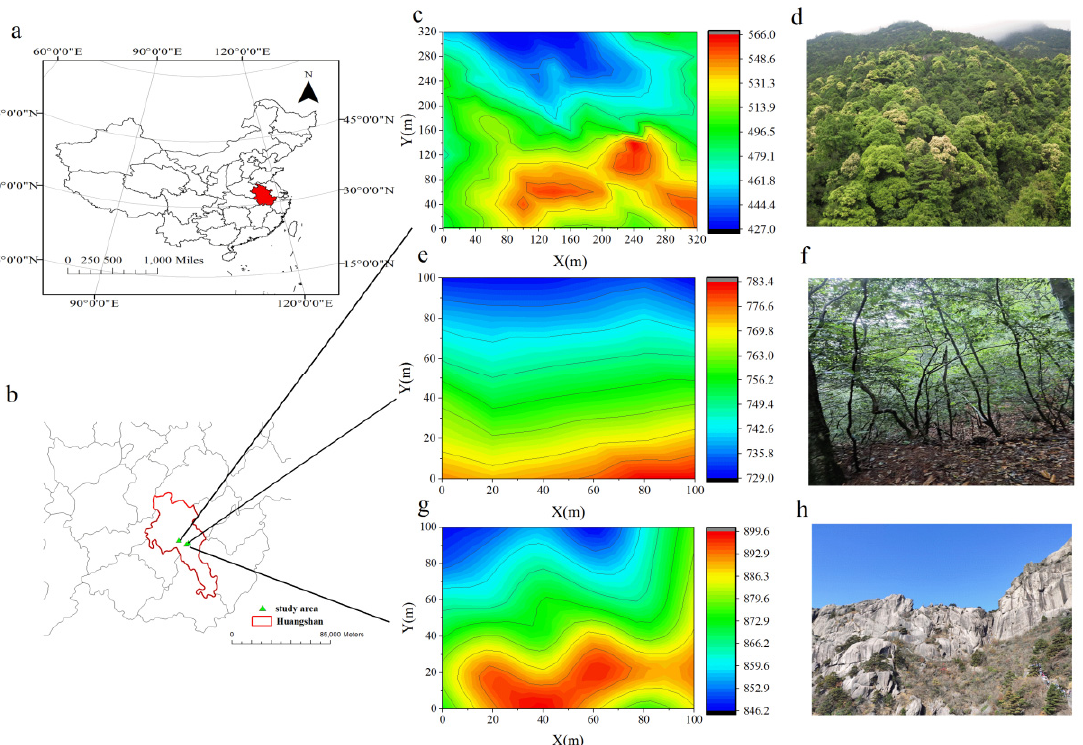
Figure 1. Location and distribution of three surveyed communities, at Mt. Huangshan ( b ), Anhui Province ( a ), East China. ( c ) Contour lines(427–566 m above sea level) and vegetation zone ( d ) of plot I. ( e ) Contour lines(729–783 m above sea level) and vegetation zone ( f ) of plot II. ( g ) Contour lines(846–899 m above sea level) and vegetation zone ( h ) of plot III.